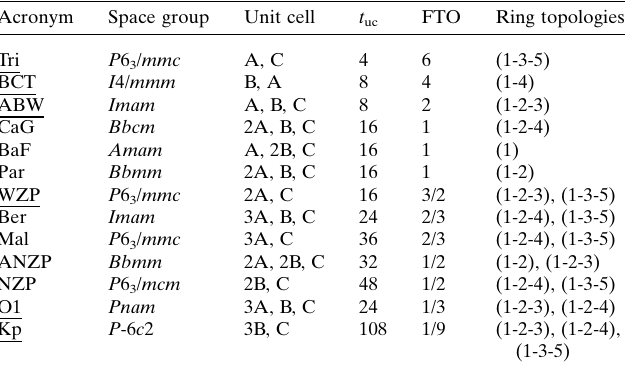
increased to (cid:9) 2 = 146 and R ( F 2 ) = 0.117. This clearly supports the microstructural origin of intensity mismatch, which is also likely to be the origin of the observed dispersion of T–O distances and atomic displacement parameters (ADPs).